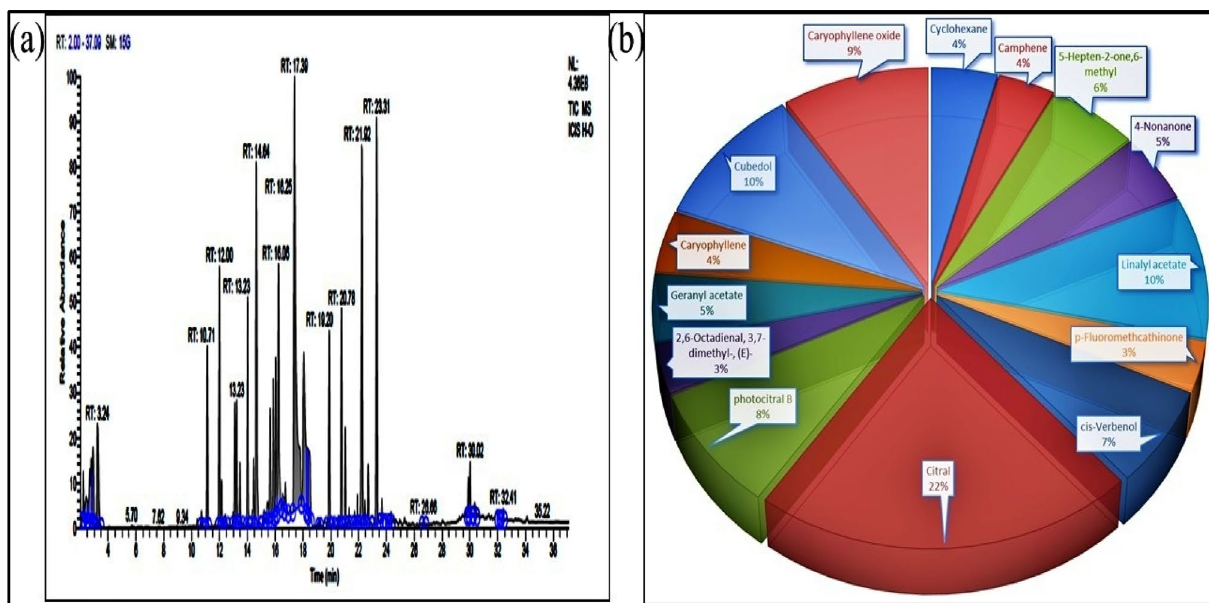
Figure 2. ( a ) Total ion chromatograms of GC–MS, ( b ) Percentage chemical composition of essential oil of C. flexuosus from site II—Haryana (S2).